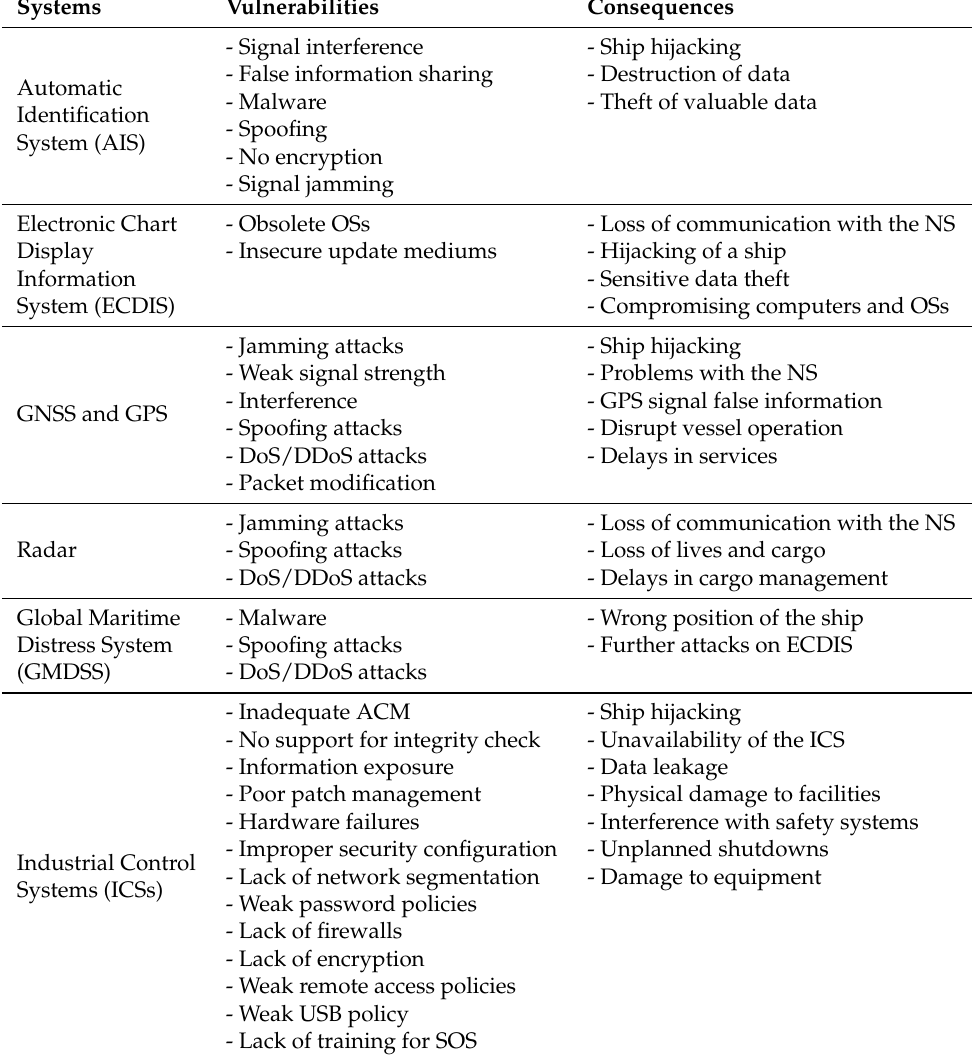
Table 2. A summary of the main vulnerabilities of modern ship systems and their